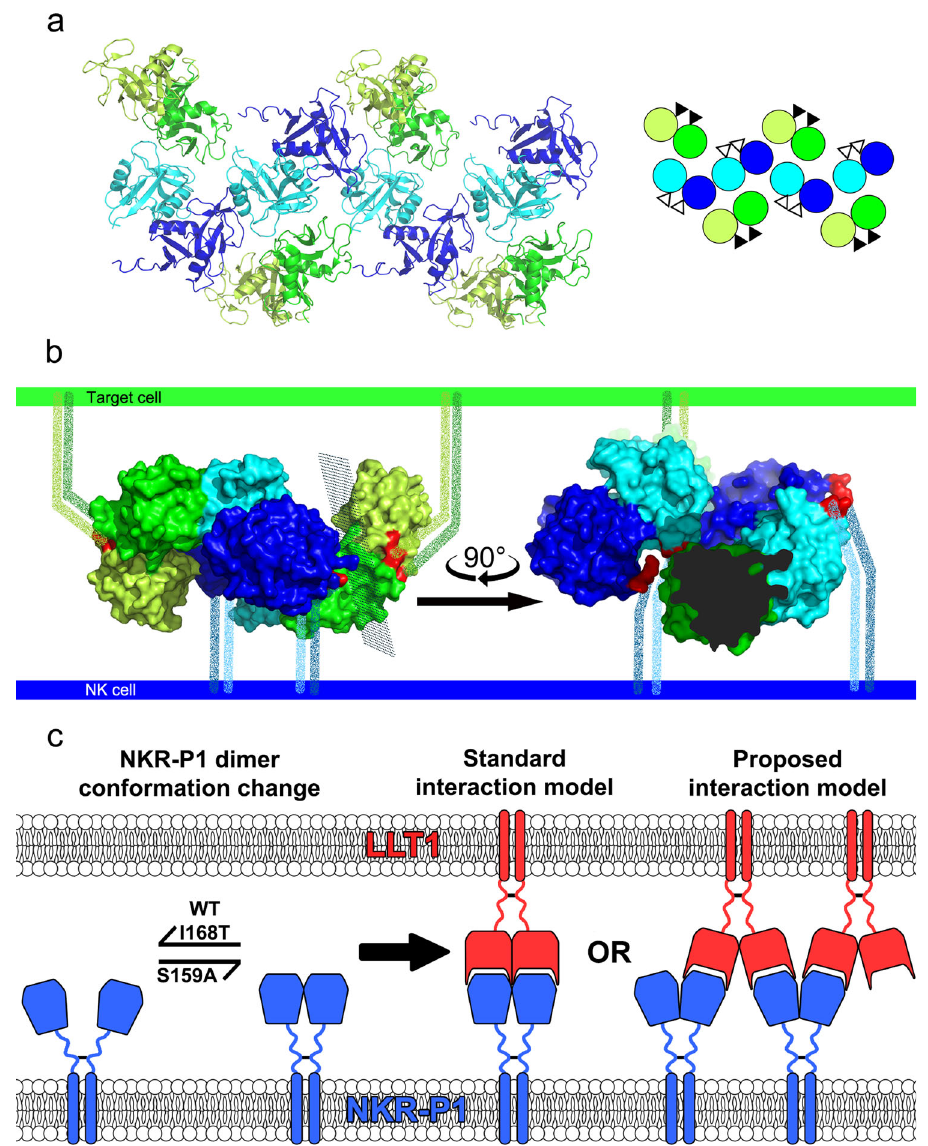
Fig. 8 | Organization of the NKR-P1:LLT1 complexes on the cell surface. a Representation of four adjacent asymmetric units within the NKR-P1:LLT1 com- plex crystal, excluding the additional unrelated NKR-P1 dimer. The NKR-P1 (blue andcyan)andLLT1(greenandlemon)dimersalternateinprimary(cyanandgreen) and secondary (blue and lemon) interactions, forming a chain-like structure. The schematic depiction of this arrangement is shown in the inset with the same color code.The blackandwhitetrianglesrepresentN-terminipositions,pointing behind and in front of the display plane, respectively. b Depiction of the hypothetical arrangement of the chain-like structure upon contact of an NK cell (bottom, blue) with a target cell (top, green) showing the crystal structure of two NKR-P1 dimers (cyan and blue) interacting withtwo LLT1 dimers (green and lemon) in the primary (cyanandgreen)andsecondary(blueandlemon)modes.The fi rstthreeN-terminal residues in the structures are highlighted in red. The fl exible stalk regions con- necting the N-termini and cell membranes are represented asspeckledlines